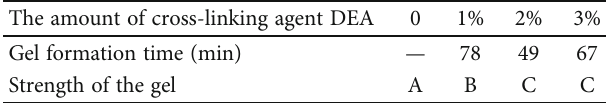
nanoparticles. 2 Table 2: The in fl uence of cross-linking agent DEA on gel.